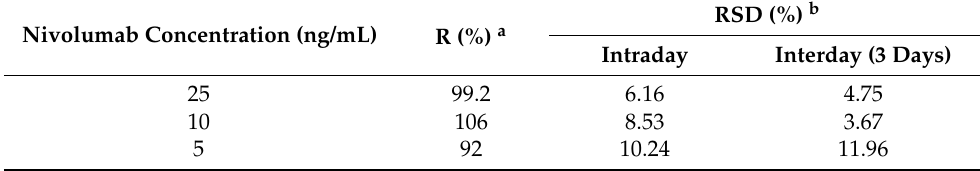
Table 8. Accuracy and precision of the ELISA.